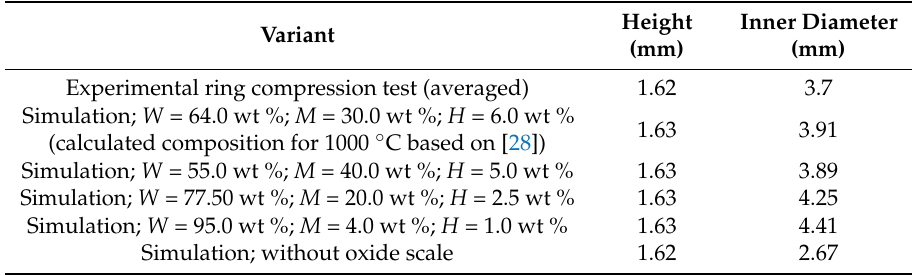
Table 5. Experimental and numerically-calculated height and inner diameter after ring compression tests for the variants with steel grade C15 at a temperature of 1000 °C.